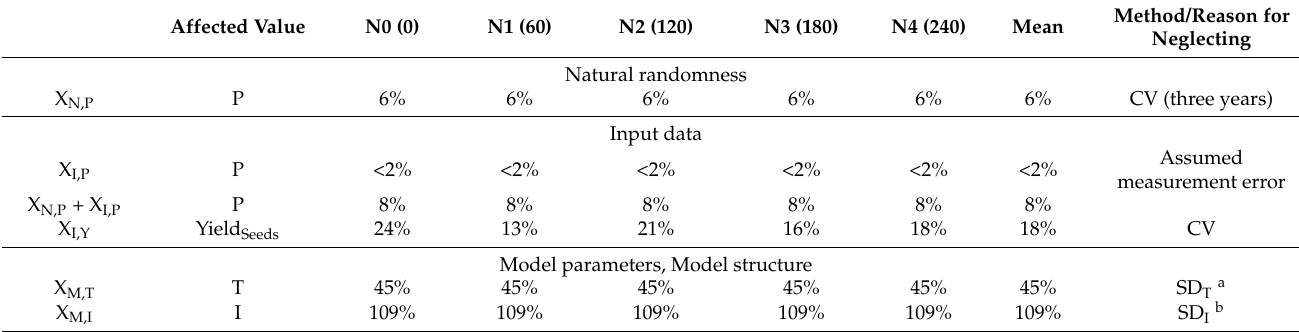
Table A2. Errors (%) stemming from natural randomness (X N ), input data (X I ), and model parameters and model structure (X M ) for the five fertilization treatments N1–N5 (kg mineral N ha − 1 a − 1 ). Variables are: CV, Coefficient of variation; I, evaporation from interception; P, incident precipitation; SD, standard deviation of the differences (SD); T,